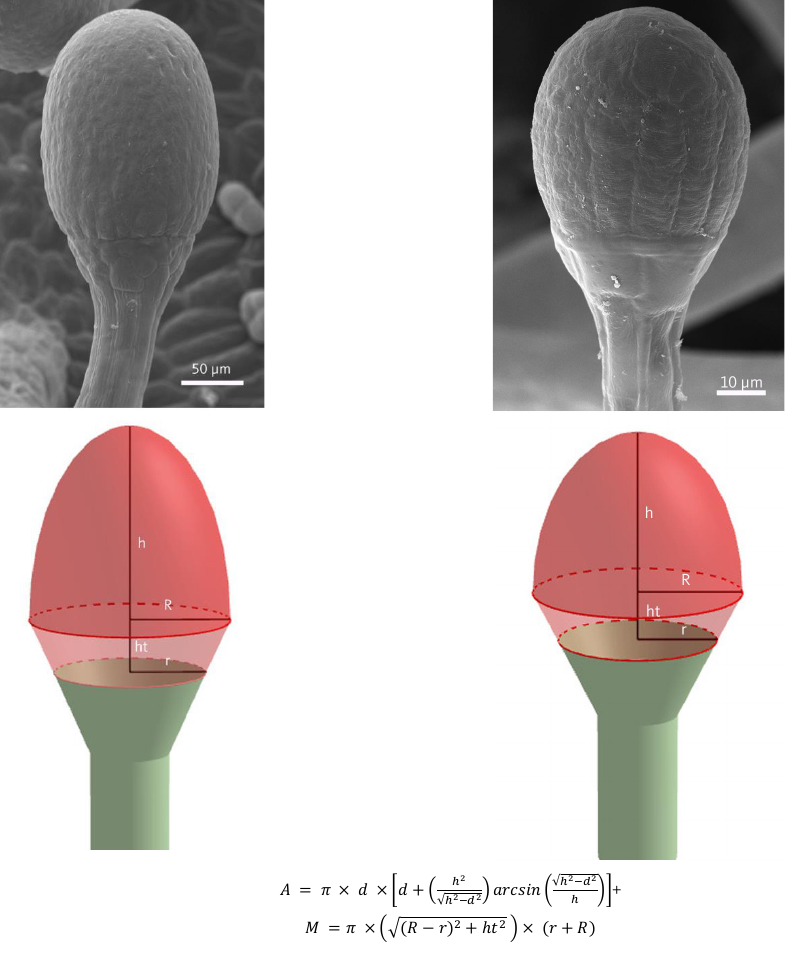
Figure 5. Morphology of the glands illustrated by SEM ( Drosera capensis , Drosera roseana) and FESEM ( Drosophyllum lusitanicum ), their approximation by geometric bodies, and formulas used for calculation of glandular surface areas (visible in shades of red). Standard deviations ( SD ) for the number of cells per gland and per trap were not calculated directly but derived from the confidence intervals (at appropriate levels, with UL CI − LL CI being the width of the confidence interval) of the surface areas of cells and glands, following the formula: